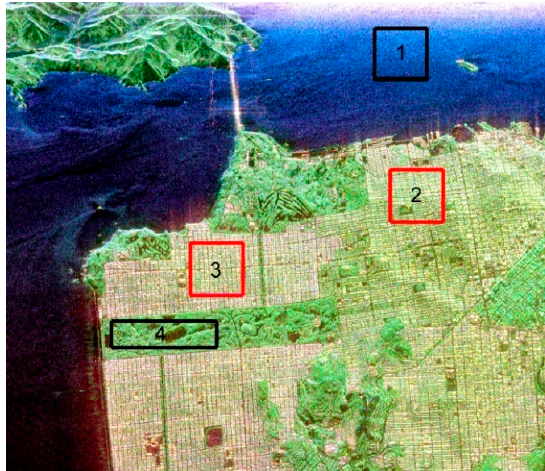
Figure 5. Pauli pseudo-color image of the AirSAR data.